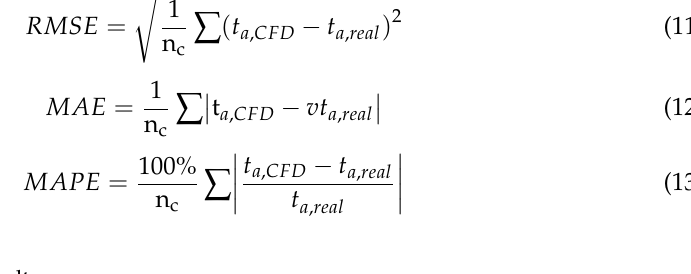
Table 8. Overview of the results accuracy.